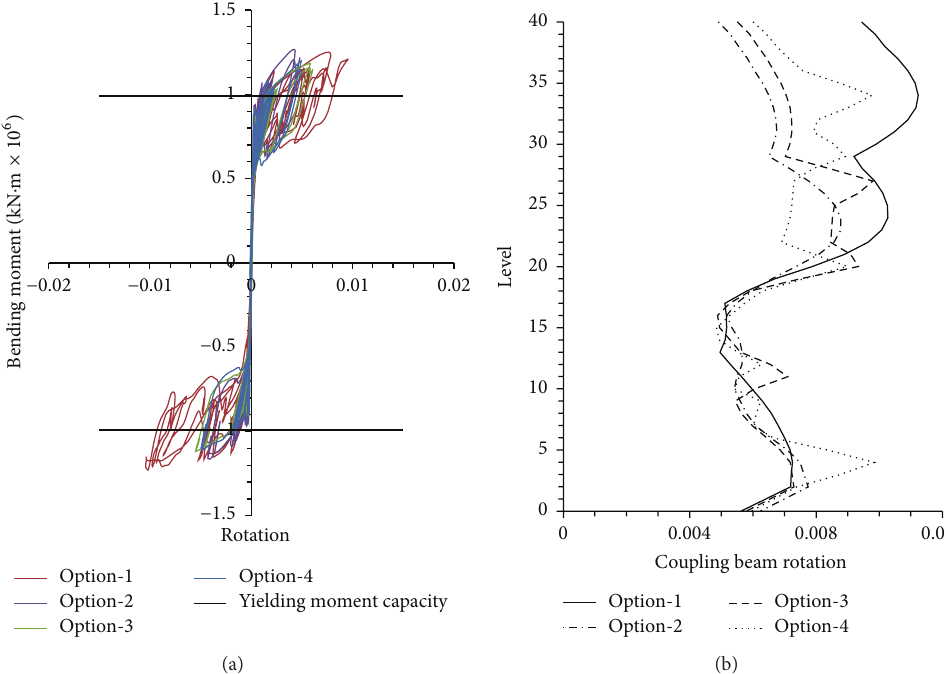
Figure 14: Inelastic rotational demands. (a) Shear walls; (b) coupling